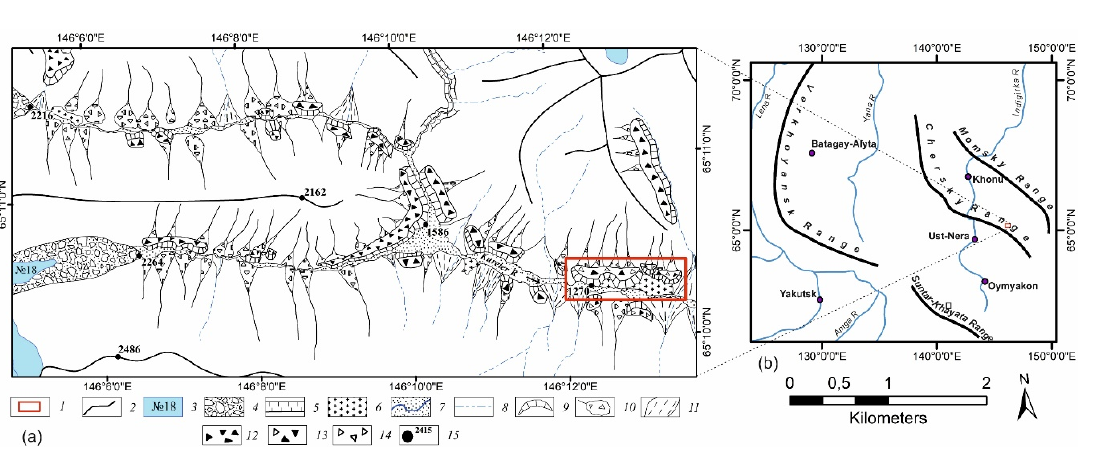
Figure 10. The key research site on the Chersky Range is marked with a red square ( b ). Glacial-periglacial complexes in the Kureter River valley ( a ). 1—footslope multi-lobe rock glacier № UC-1; 2—Range crests; 3—glaciers as numbered in the USSR Glacier Inventory; 4—Late Holocene moraines; 5—erosional cliffs; 6—riegels; 7—floodplain and channel of modern streams; 8—temporary streams; 9—steep fronts of rock glaciers; 10—avalanche talus cones; 11—proluvial cones; 12—surface of active rock glaciers; 13—surface of inactive rock glaciers; 14—surface of relict rock glaciers; 15—altitudes. The multi-blade sloping rock glacier No. UC-1 (65°10 ′ N; 146°12 ′ E) is located in the middle